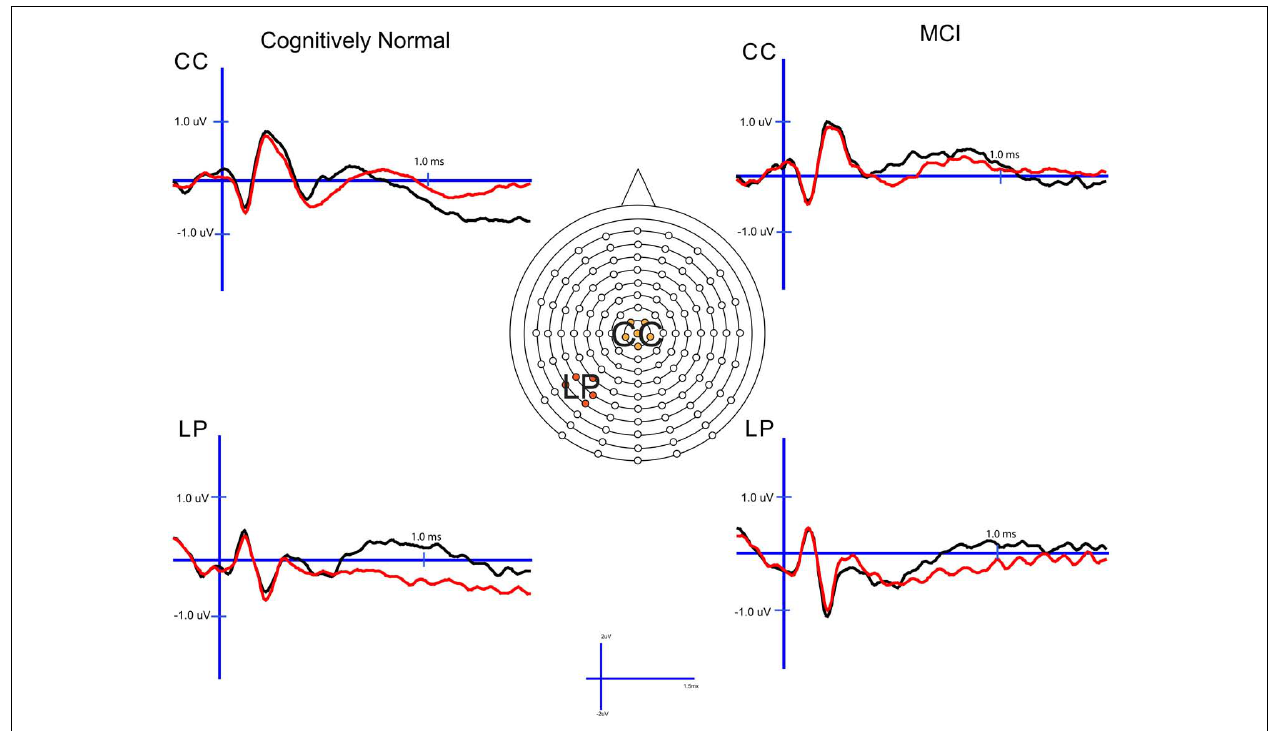
FIGURE 2 | Cognitively normal and amnestic mild cognitive impairment grand average ERP waveforms for hits (black) and correct rejections (red) in the midline central (CC) and left parietal (LP) sites. Waves were generated from the 1 × study condition in the CN group and the 3 × study condition in the amnestic mild cognitive impairment